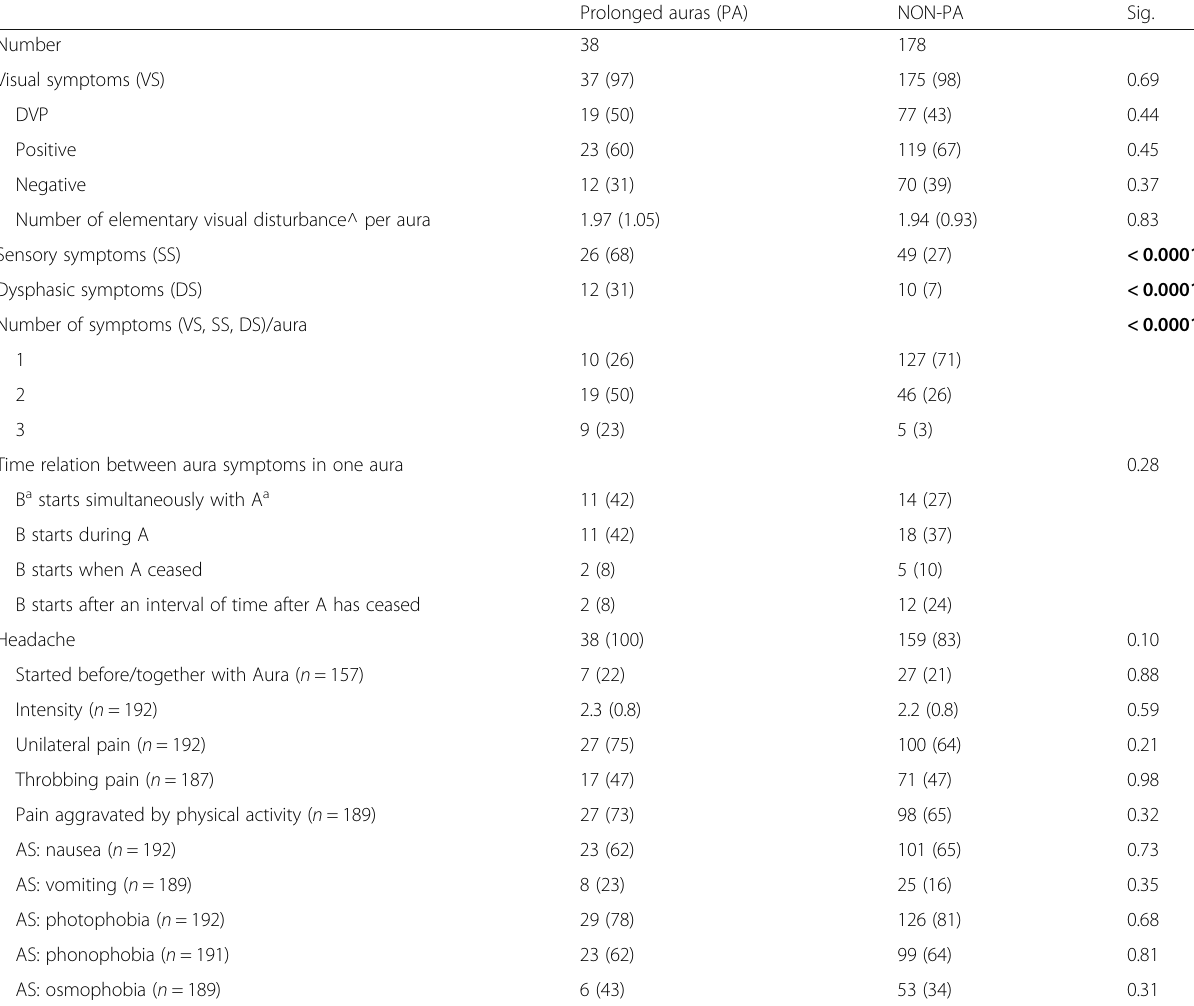
Table 2 Characteristics of PA (auras with at least 1 symptoms lasting > 1 h) and NON-PA Prolonged auras (PA)